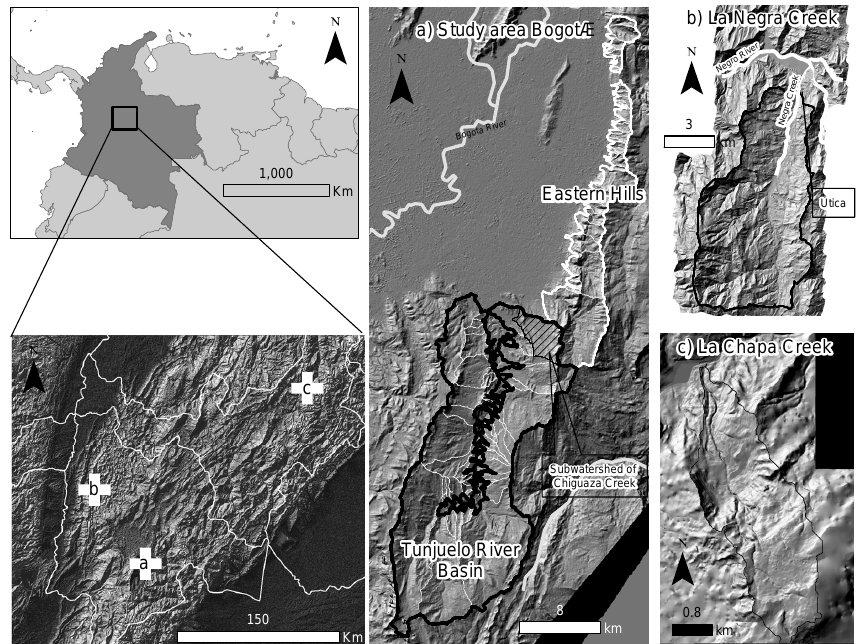
Figure 1. Location of the study